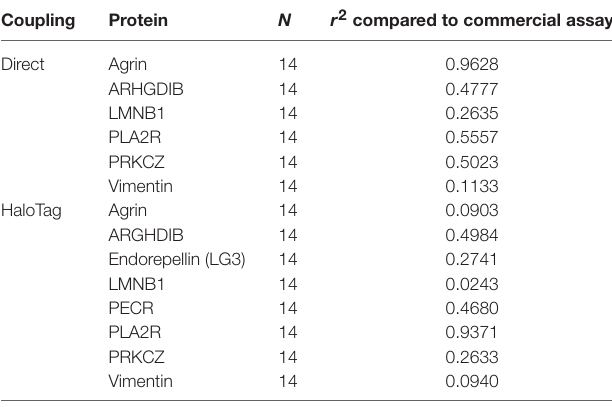
TABLE 3 | Correlation between the baseline calculations of our direct- and HaloTag-coupled multiplex assay to the commercially available Autoantibody